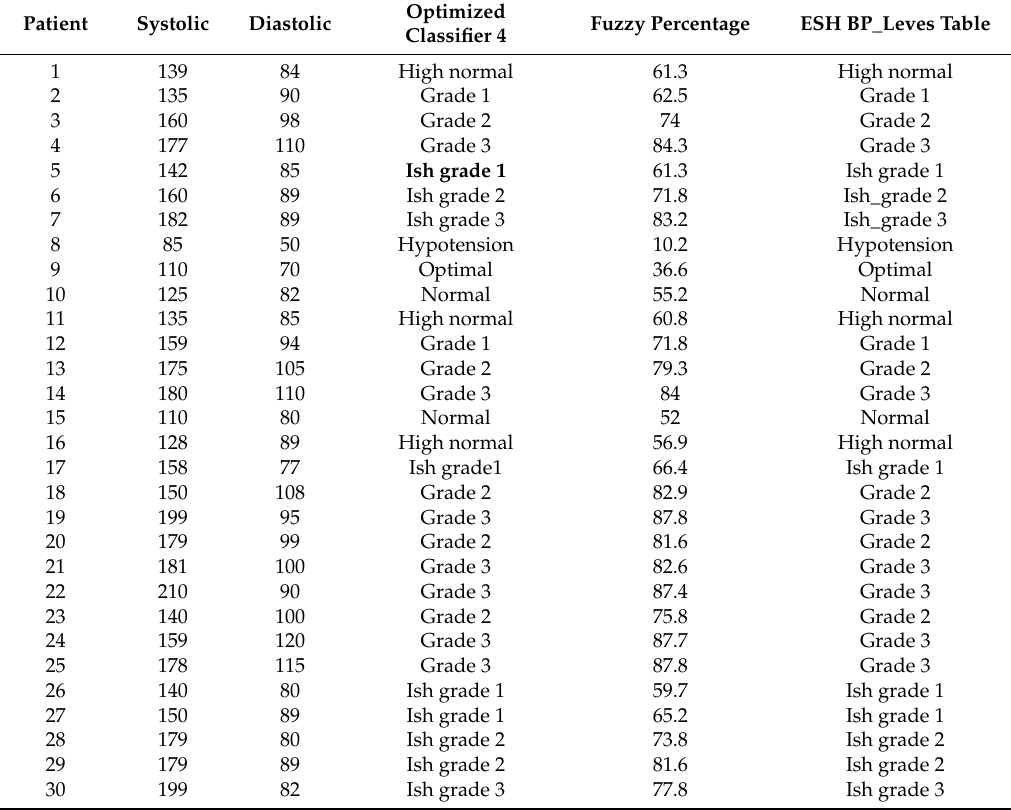
Table 10. Shows the results of the 30 patients who were monitored and classified in the classifier optimized with